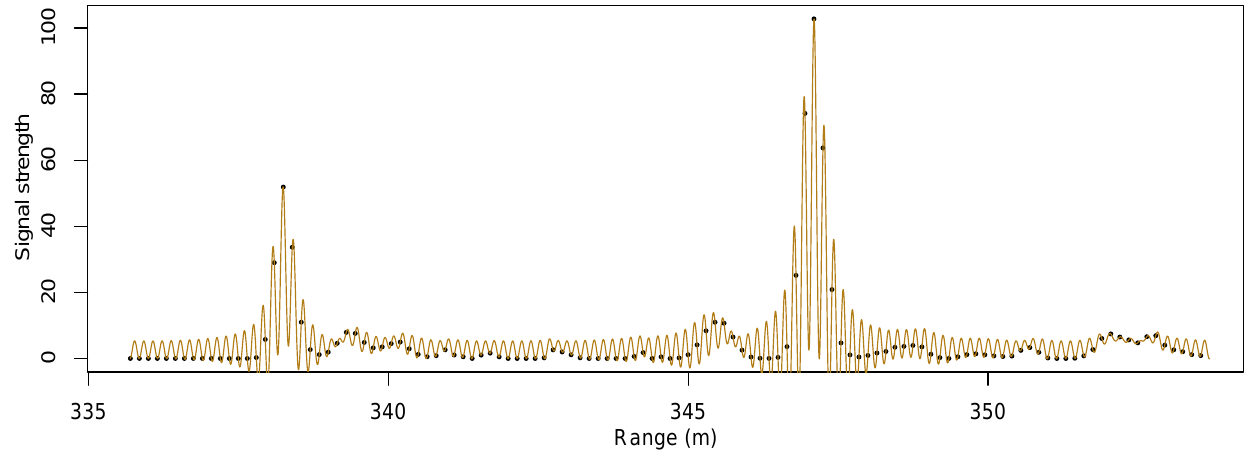
Figure 4. The combination of all component waves from the discrete Fourier transform, given in Equation (15), passes through each point in the original time